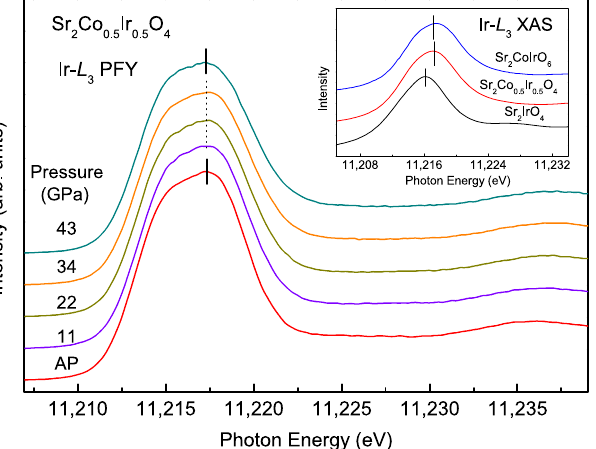
Figure 5. Pressure-dependence of the Ir- L 3 PFY spectra of Sr 2 Co 0.5 Ir 0.5 O 4 . Inset shows the Ir- L 3 XAS spectra of